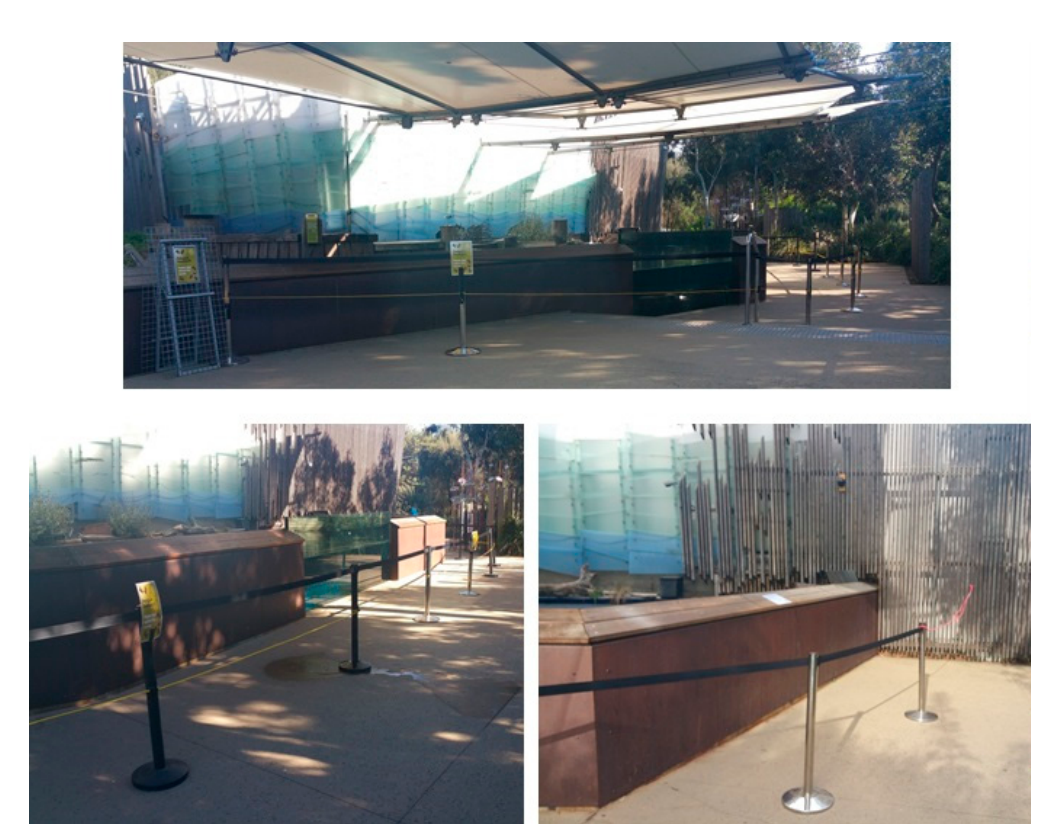
Figure 2. Setup of the barrier in the exhibit area.